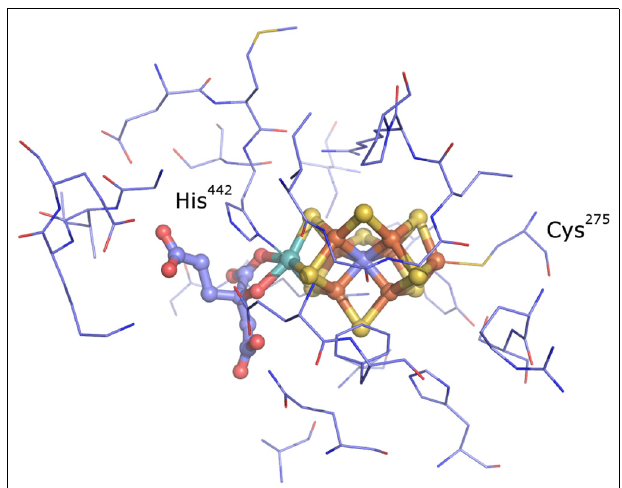
FIGURE 1 |The active site of nitrogenase from A. vinelandii (Einsle etal., 2002; Lancaster etal., 2011; Spatzal etal., 2011). The metal cofactor–homocitrate complex is shown as balls and sticks and the residues found to be within 5 Å of the cofactor are shown as lines (thin). Colors : light blue, carbon; blue, nitrogen; red, oxygen; yellow, sulfur; rust, iron; cyan, molybdenum.